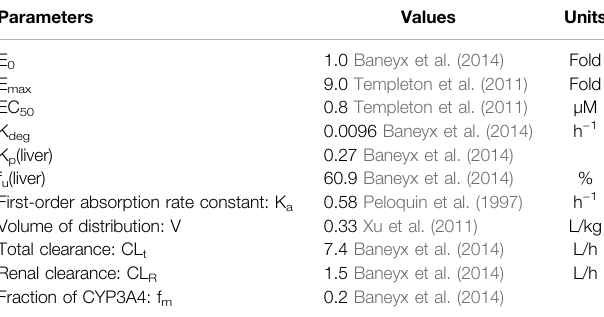
TABLE 2 | Parameters used in the induction model.